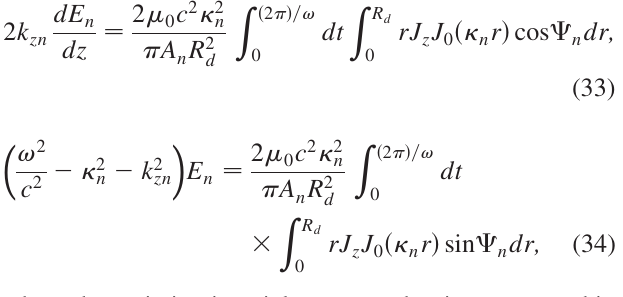
¼ (cid:4) Im ð k Þ R R spatial growth rate, (cid:3) for the TM 01 and n d zn d ¼ 1 . The maximum TM 02 modes for a 50 A beam with (cid:1) spatial growth rates occur at 8.12 and 26.26 GHz for the TM TM 01 and 02 modes, respectively. figuration defined by Eqs. (33)–(38) were solved for the TM TM 01 and 02 modes for our set of parameters using ¼ 30 and N ¼ 128 which conserved energy to within N r (cid:10) 0.1% for both TM 01 and TM 02 modes. Figures 6 and 7 show the evolution of the microwave power and average beam energy for the TM 01 and TM 02 modes. The evolution of growth rate and wave number is shown in Figs. 8 and